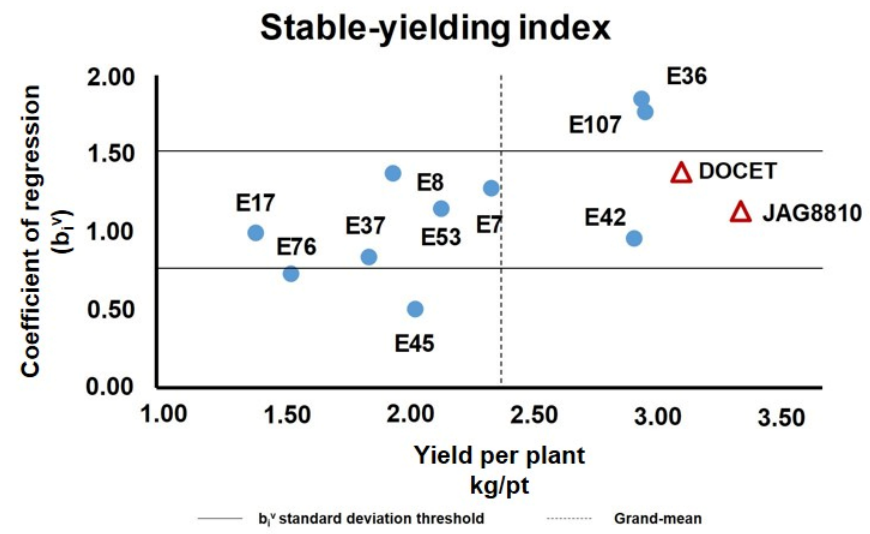
Figure 2. Diagram showing the stable-yielding index evaluated in the 12 genotypes analyzed. Yield / pt (YP) averages of each genotype over four environments were plotted against their coefficient of regression, calculated as reported in Supplementary Table S6. The horizontal lines delimitate the range of variation of the b iv index between 0.77 and 1.57. The dashed vertical line indicates the grand mean YP value.